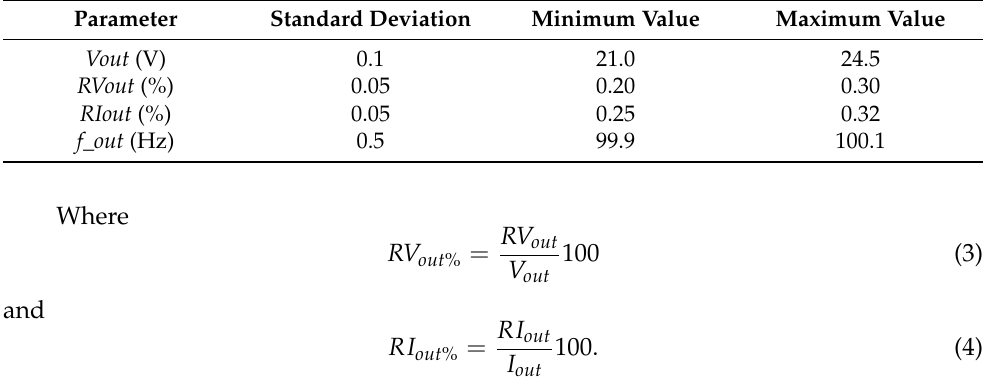
Figure 12. Link between harmonics of current on AC ( Iin ) and DC ( Iout ) sides. Therefore, RTHD_I and RTHD_V have been evaluated and reported in Table 4 with the normalized standard deviations evaluated applying the following formulas: 𝜎𝑅𝑇𝐻𝐷_𝐼 % = 𝜎𝑅𝑇𝐻𝐷_𝐼 𝑅𝑇𝐻𝐷_𝐼 100